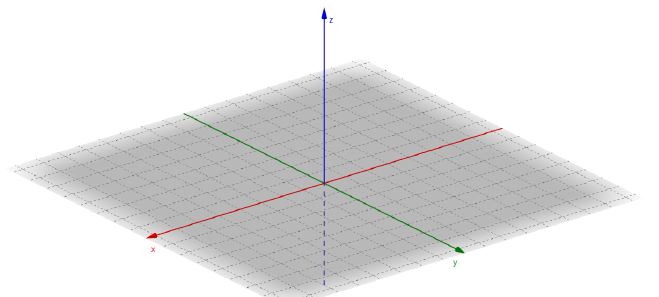
Figure 4. Cartesian space.